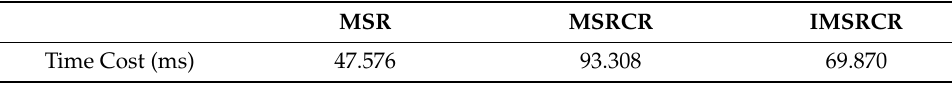
Table 3. The Time Consumption of Color